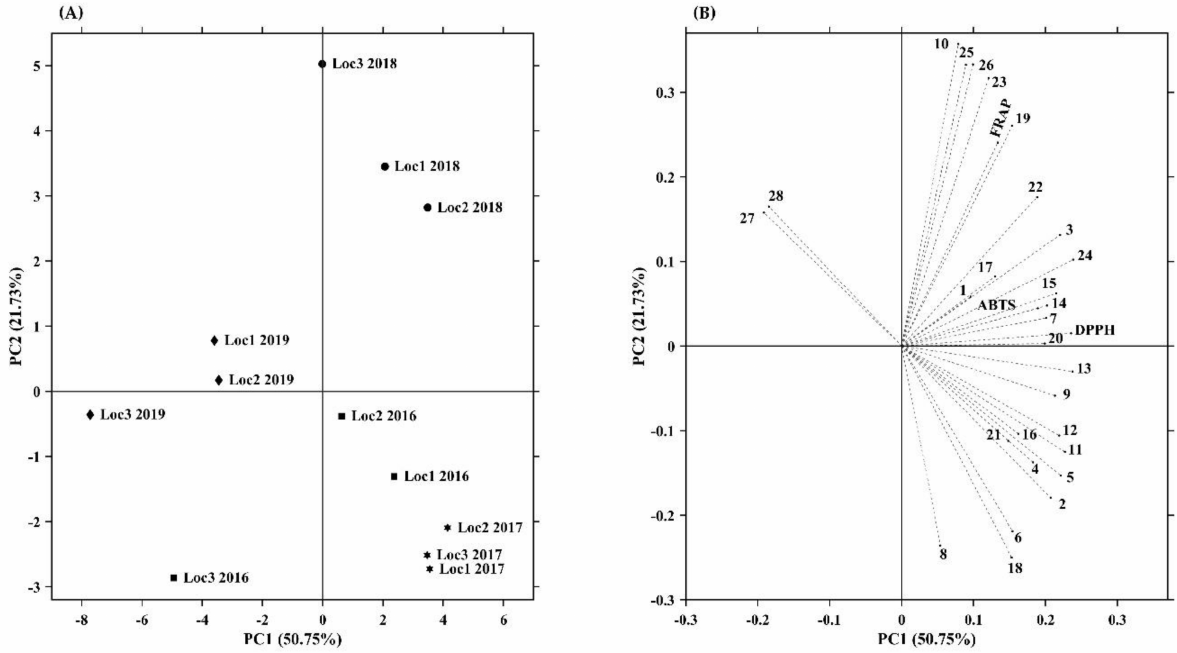
Figure 2. Principal component analysis (PCA) scores ( A ) and loadings plot ( B ) of phenolic composi- tion and antioxidant capacity of Prunus lusitanica fruits. Abbreviations: Numbers 1–28 are phenolic compounds presented in Tables 1 and 2; FRAP. ferric reducing antioxidant power; DPPH.